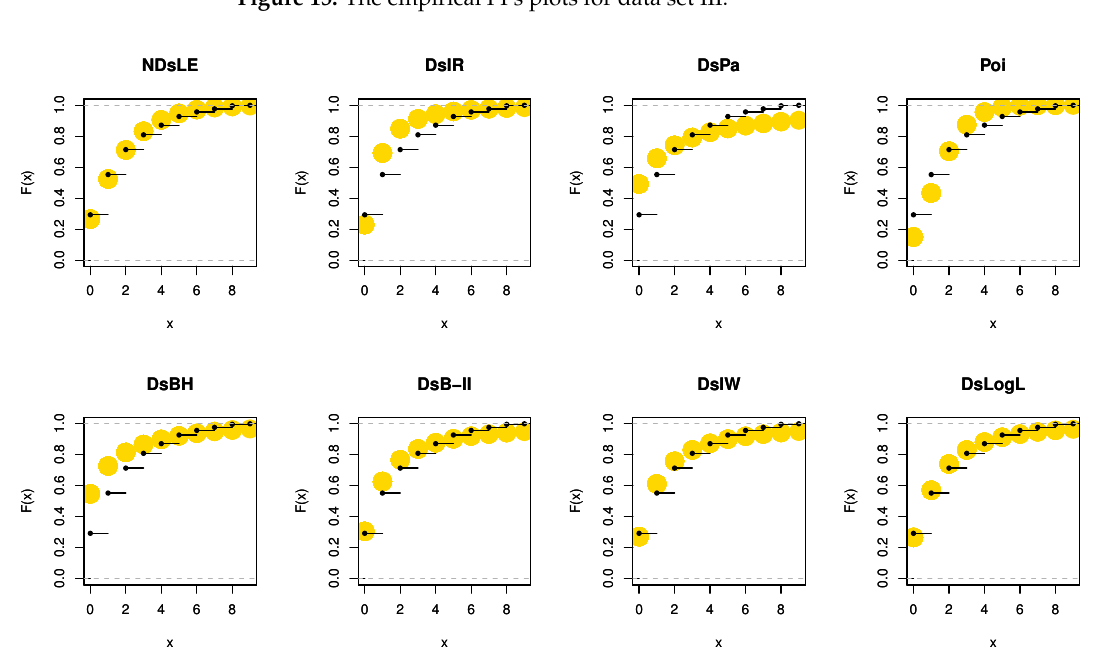
Figure 16. The empirical CDFs plots for data set III. Table 13 lists various estimators for data set III; it was found that the MLE and MoE techniques worked quite well for modeling data set III, but the MLE method was the best. Table 14 listed some numerical accounts of empirical and theoretical descriptive statistics. It is clear that all scales were approximately